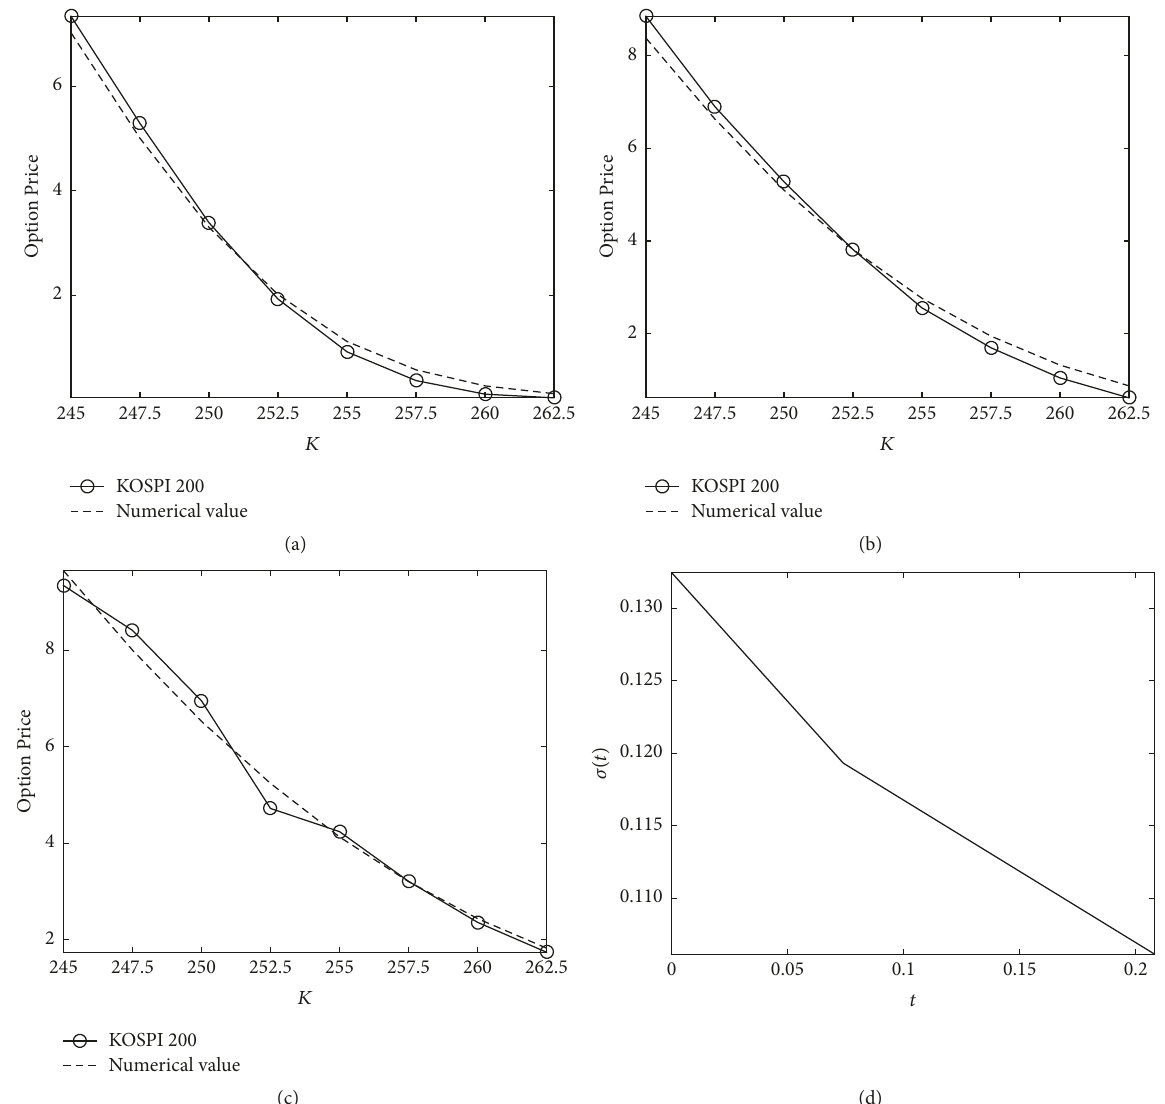
Figure 8: Comparison of KOSPI 200 index call option price (circle-marked solid line) with numerical option prices (dashed line) at (a) 𝑇 = 13/365 , (b) 41/365 , and (c) 76/365 . (d) Constructed time-dependent volatility